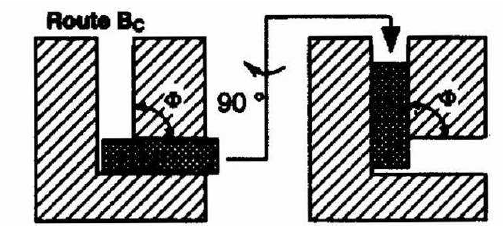
Fig. 3. Equal Channel Angular Pressing Technique [13].